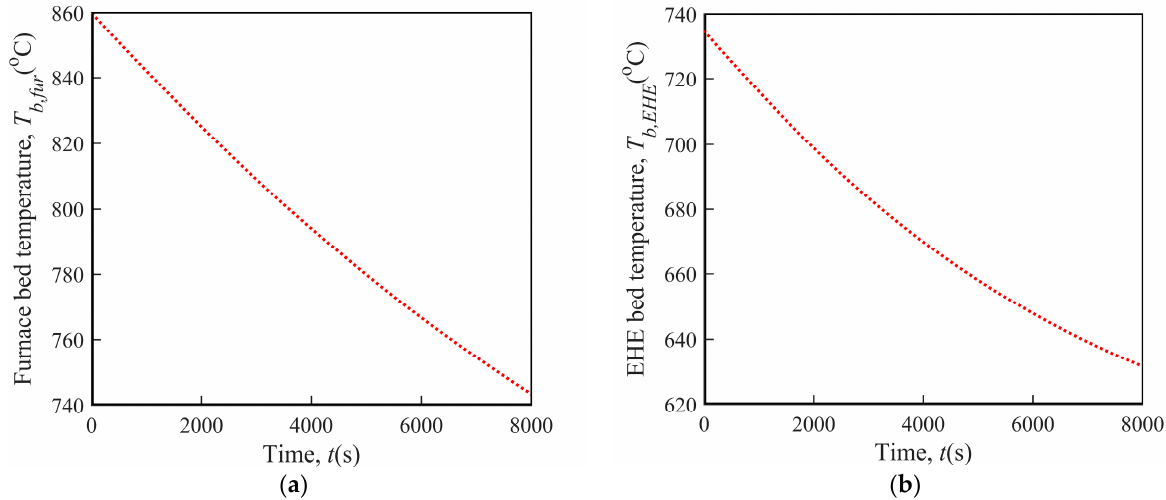
Figure 4. Variation of bed temperature under sudden electricity failure. ( a ) Furnace bed temperature; ( b ) EHE bed temperature.